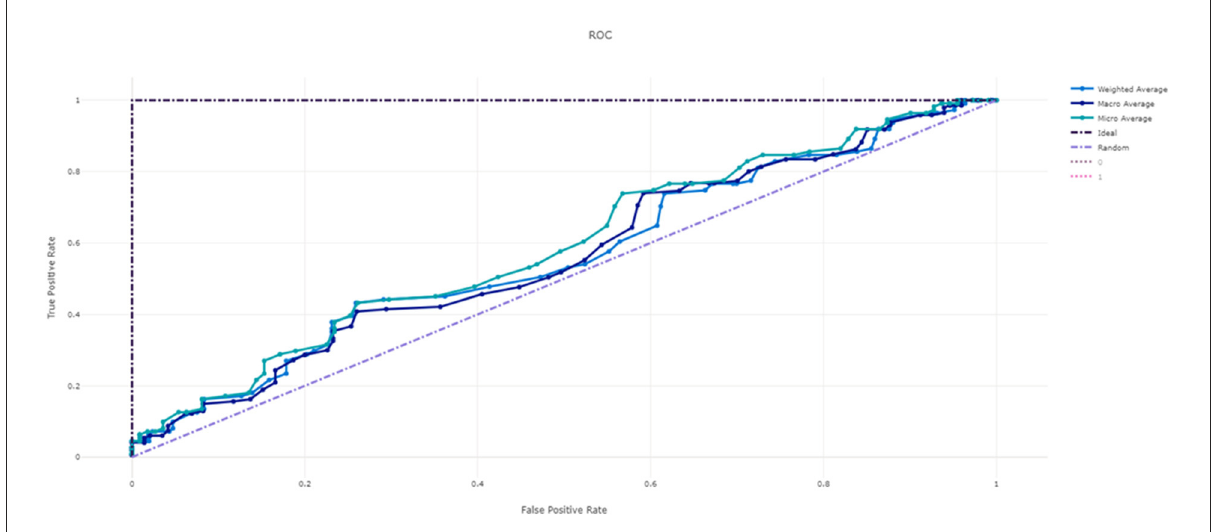
FIGURE7 ROC curve of SGD model predicting fall risk among hospitalized elderly.